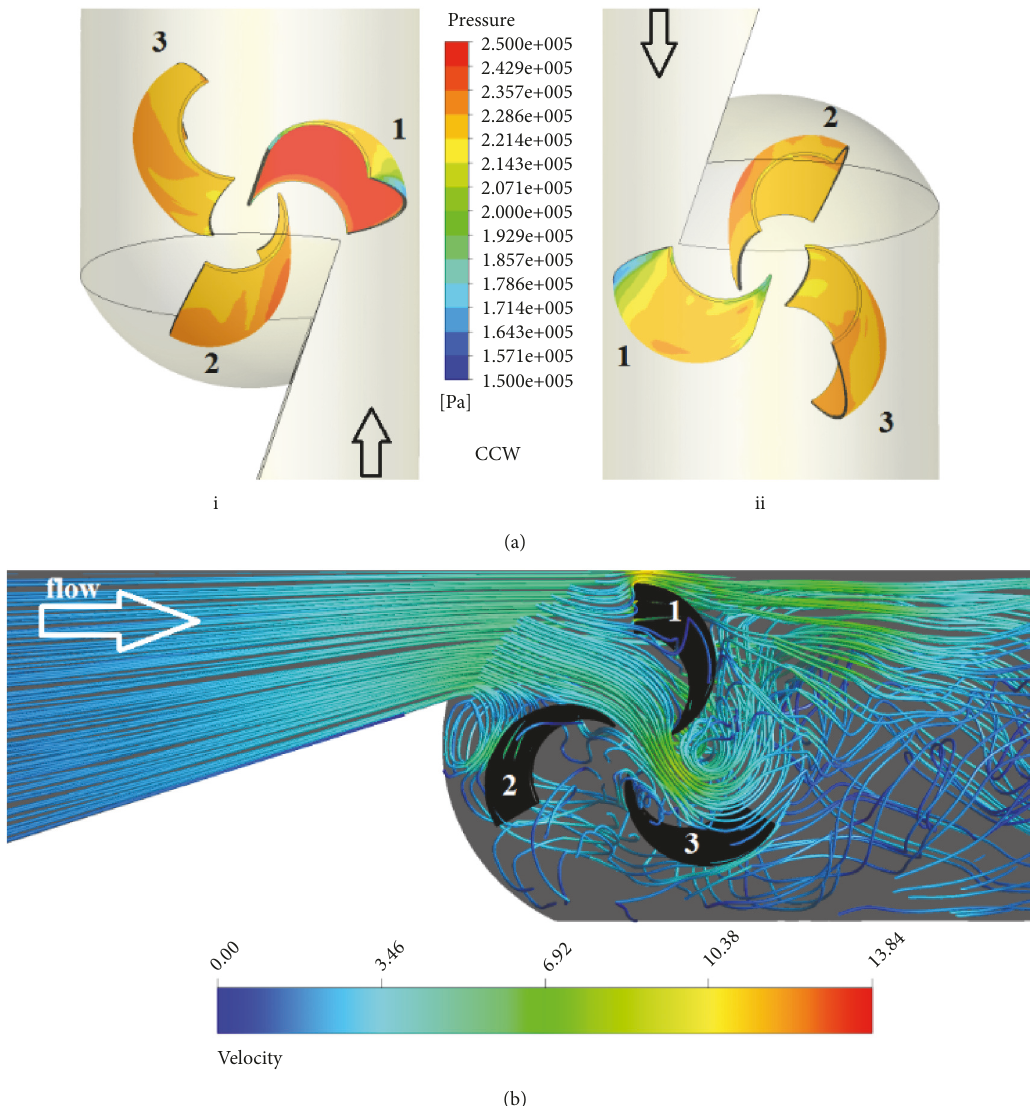
Figure 10: The simulated fluid flow around the 3-bladed turbine: (a) pressure contours (i) in the direction of flow view and (ii) in the opposite direction of flow view and (b) top view of